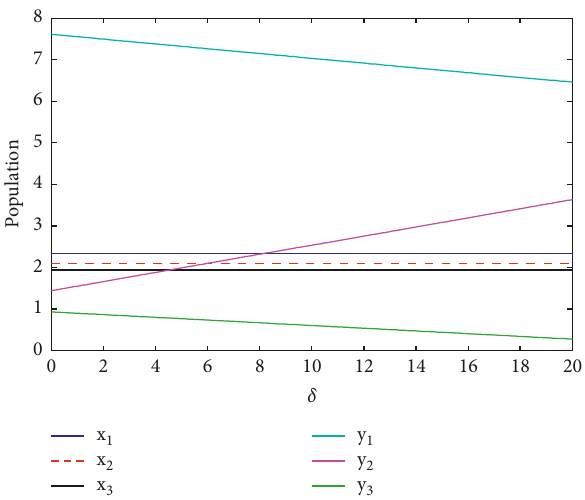
Figure 20: Trophic cascade of all species in our proposed system with changing dispersal rate.